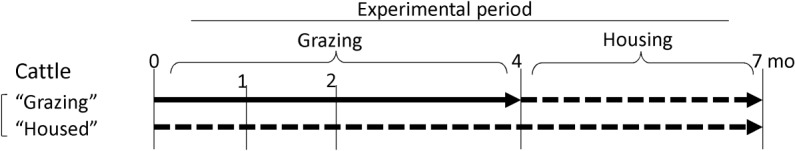
Scheme of the experimental period for investigation of gene expression in grazing JSH cattle.Solid and broken lines indicate grazing and housing of cattle, respectively.